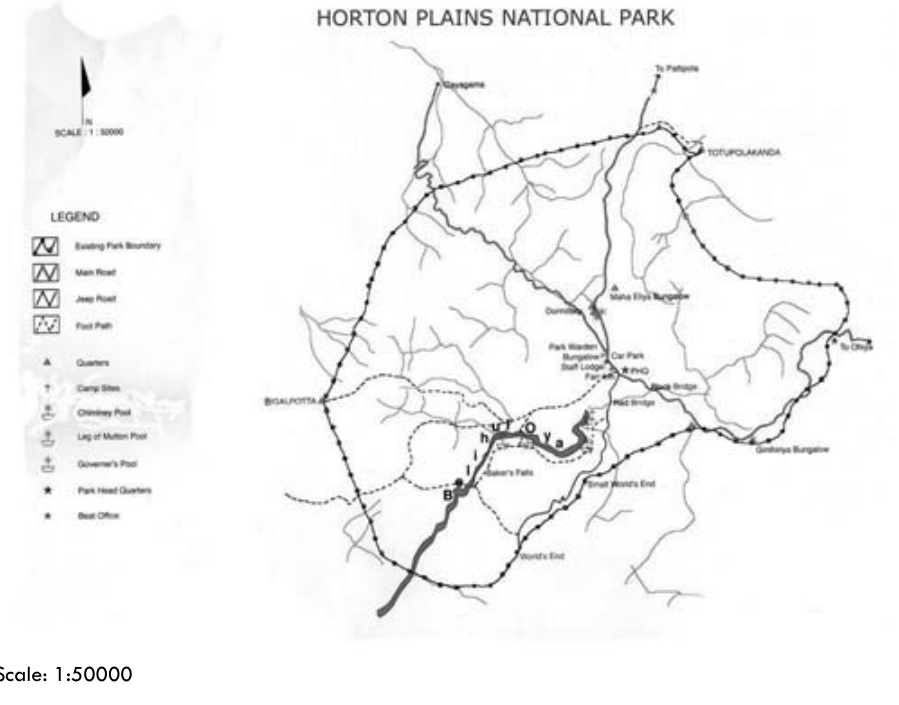
Figure 1: Map of Horton Plains National Park with view